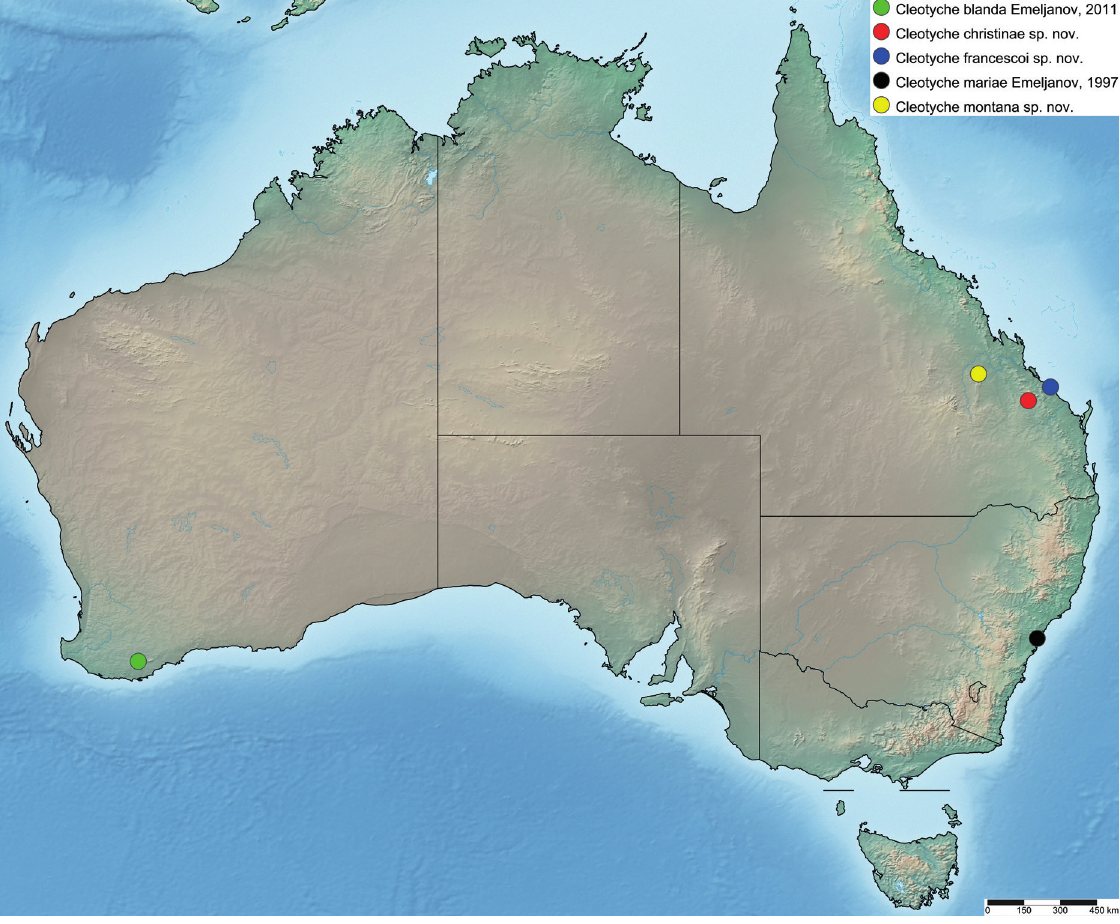
Fig. 6. The distribution of described species of Cleotychini in